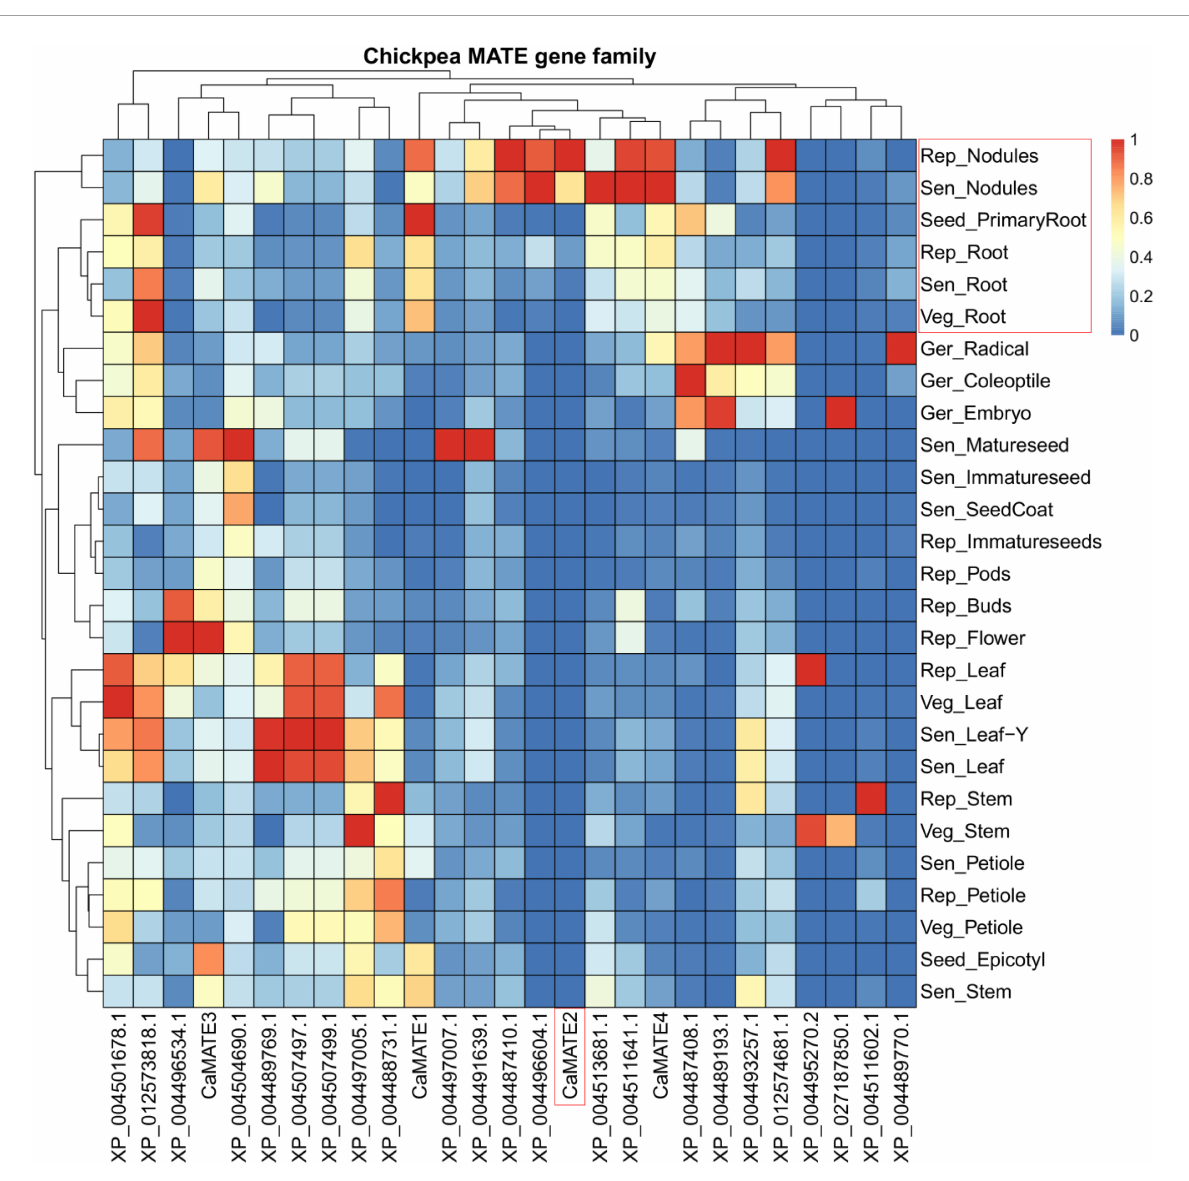
FIGURE4 Transcriptional heat-map of Cicer MATE genes across different tissues. Transcriptional data for MATE domain containing genes in various tissues under different developmental stages were retrieved from the chickpea gene expression atlas and were scaled based on the maximum RPKM value of individual genes. Genes and tissues were clustered based on their expression profiles using pheatmap software (Kolde, 2015). Only those genes with matches in the NCBI annotation (ASM33114v1 annotation Release 102) were included. Root-specific CaMATE2 and root-related tissues were highlighted in the red